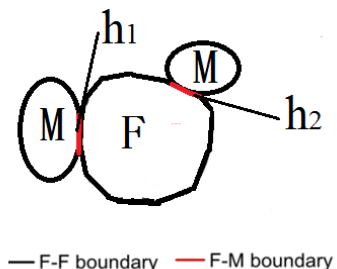
Figure 5. Relative grain-boundary coverage.